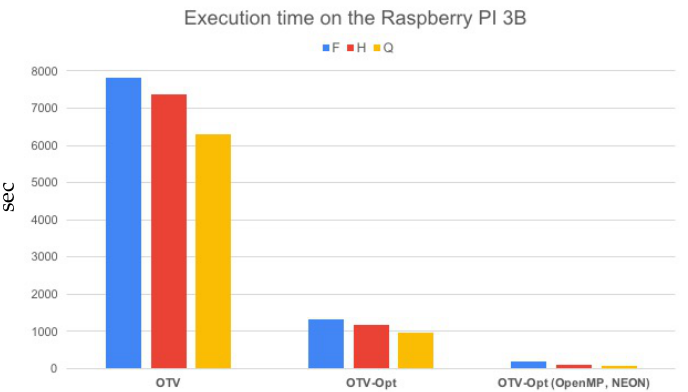
Figure 11. Execution time in seconds, at the three resolutions (F, H, Q), on the Raspberry Pi 3B. The original OTV algorithm [25] ( Left ), the optimized counterpart OTV-Opt obtained through the functional optimization (Middle), OTV-Opt exploiting the parallel computing capabilities of the target device ( Right